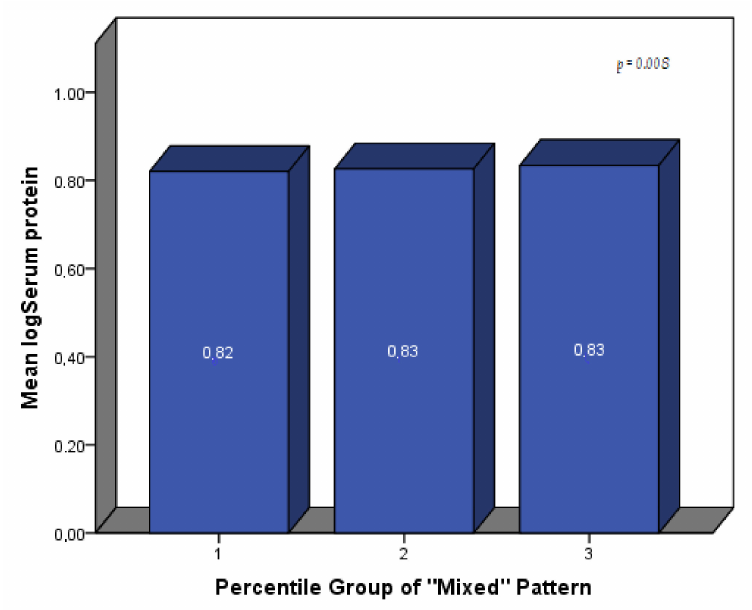
Figure 6. Percentile distribution and associations between the “Mixed” Pattern and logSerum Protein values.